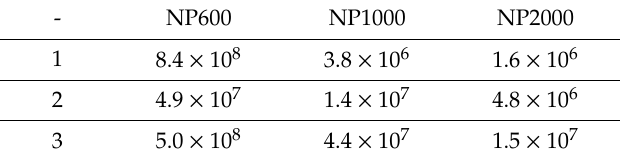
Table 1. Total particle count using di ff erent Nanopore sizes (qNANO) in biological